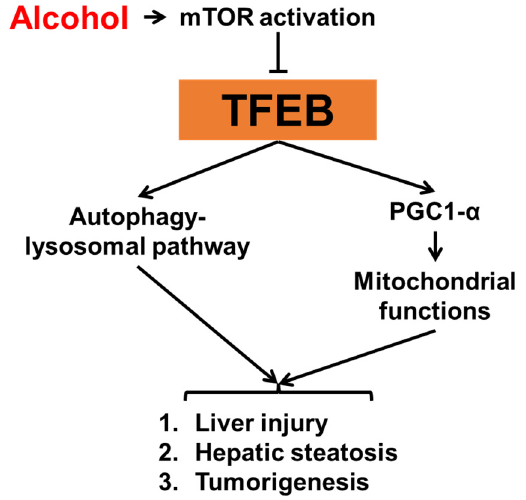
Figure 2. The role of TFEB in alcohol-associated liver injury.